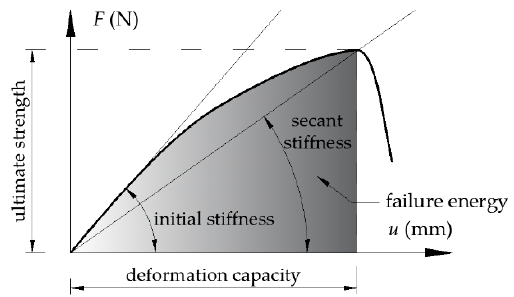
Figure 8. Blind rivet in sandwich panels – connection characteristic.